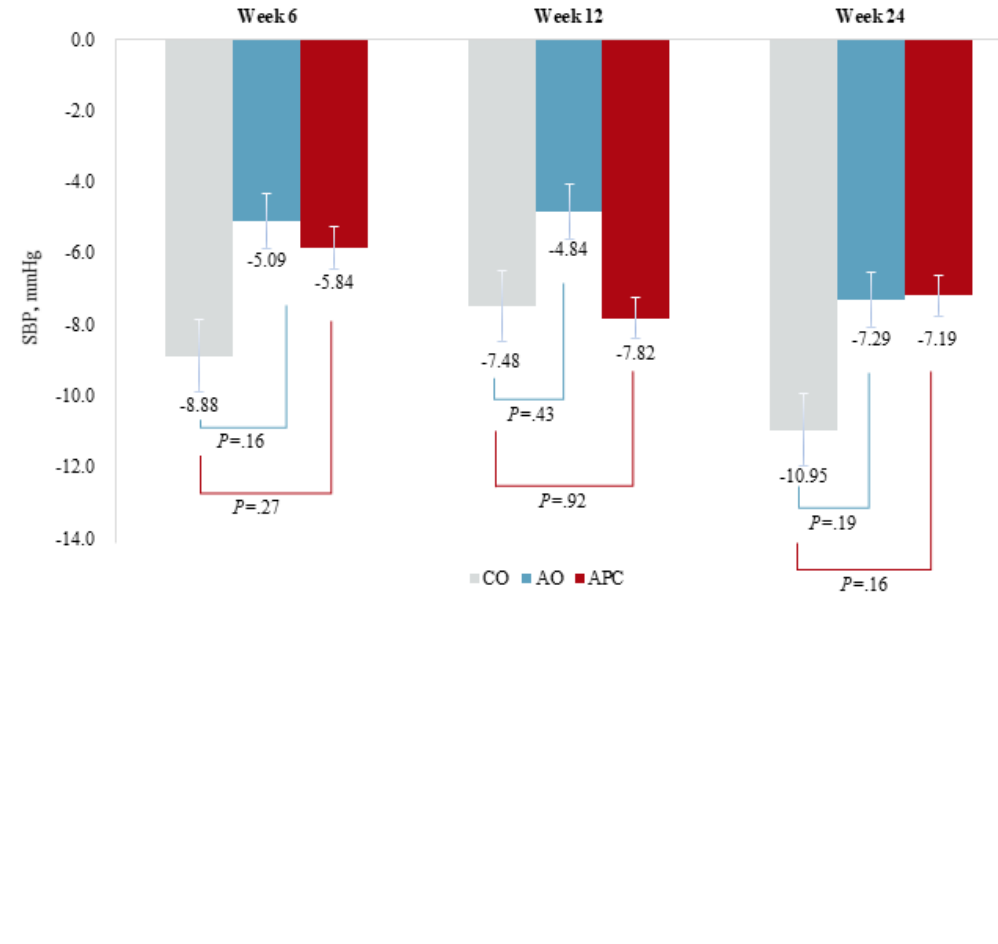
Figure 3. Systolic blood pressure changes from the baseline across the 3 groups at each time point. AO: app-only; APC: app with personalized coaching; CO: control, SBP: systolic blood